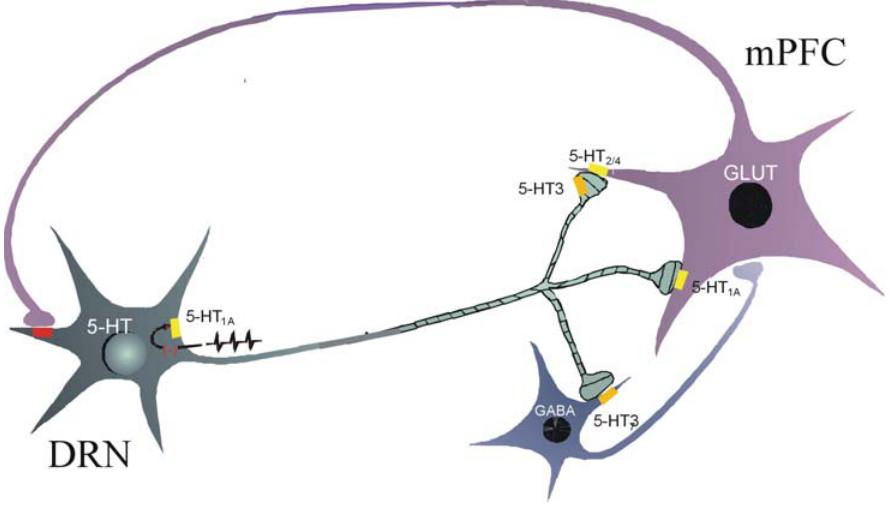
Figure 1. Hypothetic model of the mechanism of action of 5-HT receptor agonists on the 3 dorsal raphe nucleus-prefrontal cortex loop. Cortical 5-HT receptors seem to be localized 3 both presynaptically on 5-HT neurons and postsynaptically on GABAergic interneurons. Stimulation of dorsal raphe nucleus induces a cortical release of 5-HT. Thus, released 5-HT may target postsynaptic 5-HT receptors inducing an activation of GABAergic 3 interneurons. These interneurons inhibit pyramidal cells that reduce 5-HT dorsal raphe neuronal firing rate. 5-HT receptors are represented in yellow except 5-HT receptors in 3 orange and ionotropic glutamatergic receptors are represented in red. DRN, dorsal raphe nucleus, mPFC, medial prefrontal cortex, GABA, gamma aminobutyric acid, GLUT,